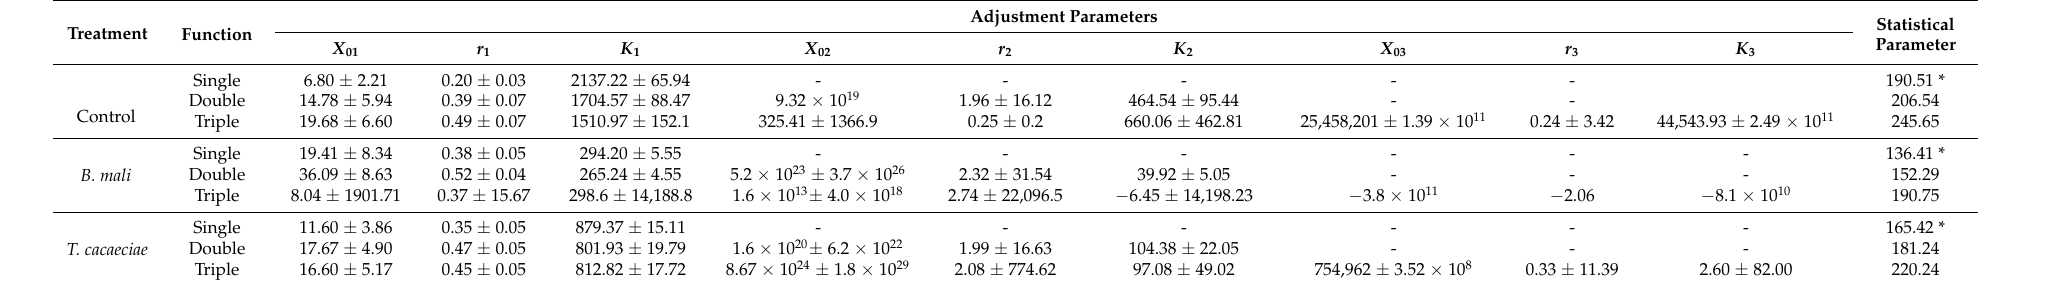
Adjustments in each treatment are indicated by * representing the best fits. n =